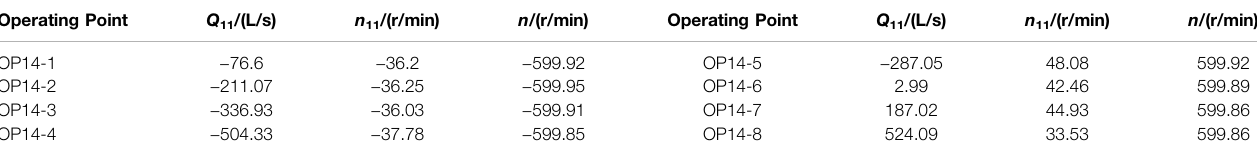
TABLE 3 | Table of operating point in CFD Simulation. (A positive value represents the direction of the turbine, and a negative value represents the direction of the pump). Operating